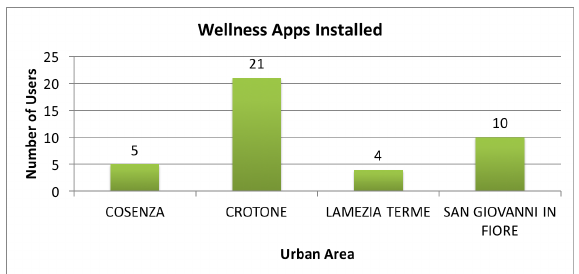
Figure 7. Details about the deployment of the Wellness